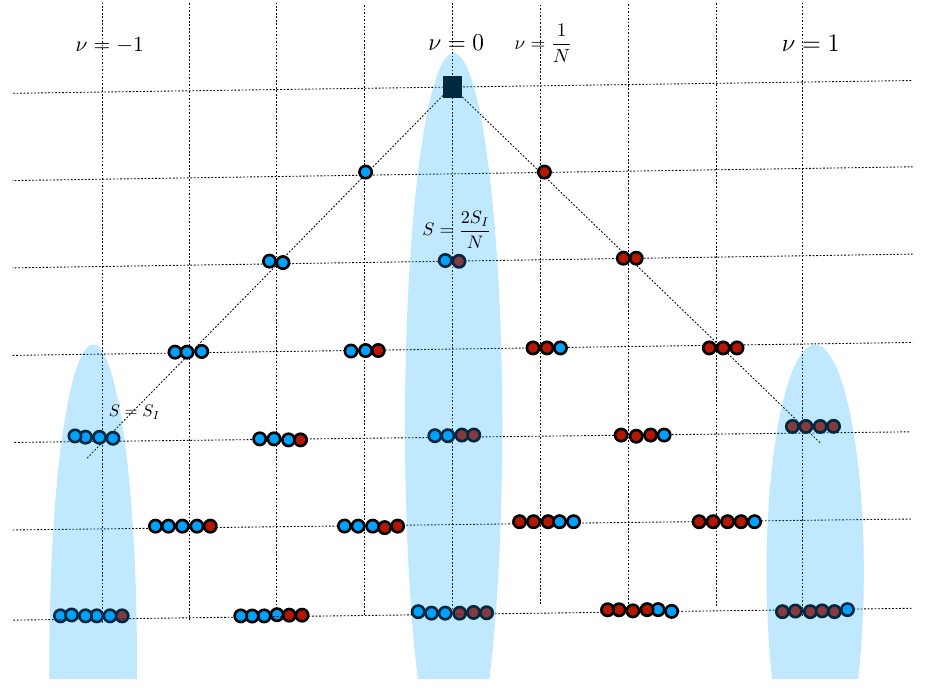
Figure 3 . Only integer winding (topological charge) configurations corresponding to periodic paths contribute to partition function. To detect fractional instantons in QM is visually trivial (See figure 1). Formally, it requires either twisted boundary condition by using shift symmetry, Z N or coupling to topological gauge theory. The latter more abstract formalism is more useful in Z N gauge theories in four-dimensions, to understand the true nature of saddles contributing to Yang- Mills theory. Despite the fact that W = 1 , S = S I /N fractional topological charge and fractional N configurations are not contributing to partition function, W = 0 , S = 2 S fractional action I /N configurations do. This is responsible for the emergence of multi-branch structure as a function of theta angle. This construction tells us that trying to understand the saddles in SU( N ) gauge theory by working directly with SU( N ) bundle is not correct. It neglects most important